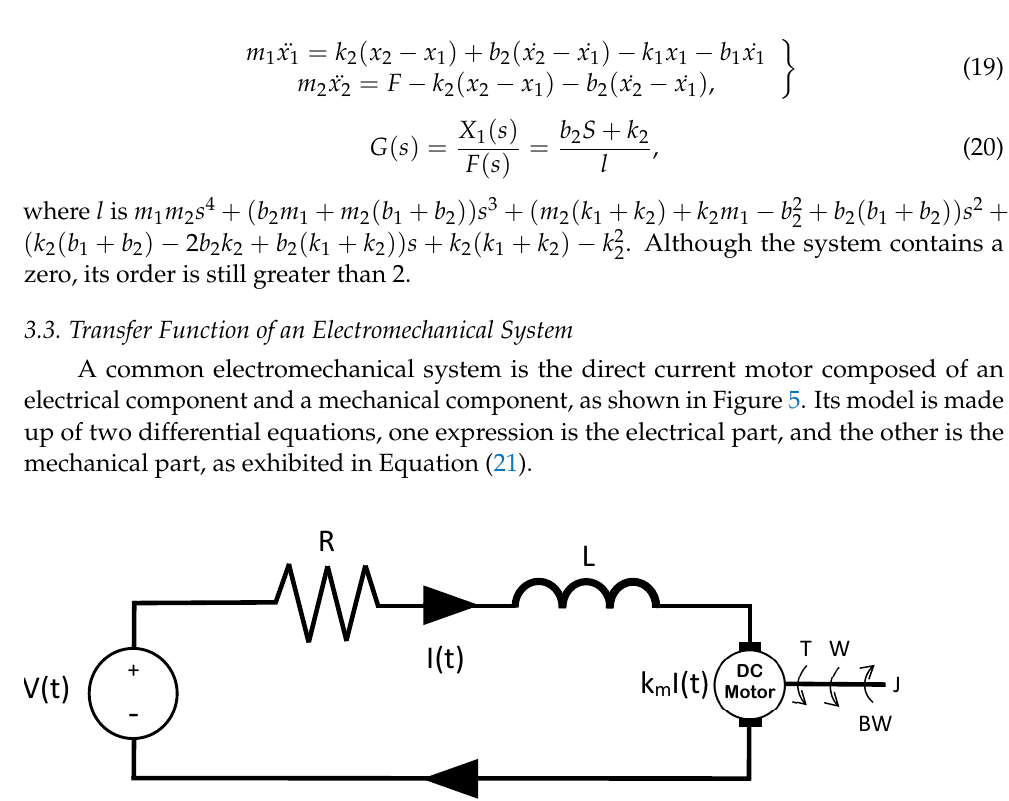
Figure 4. Mass-spring-damper to obtain the high-order transfer function in mechanical systems.